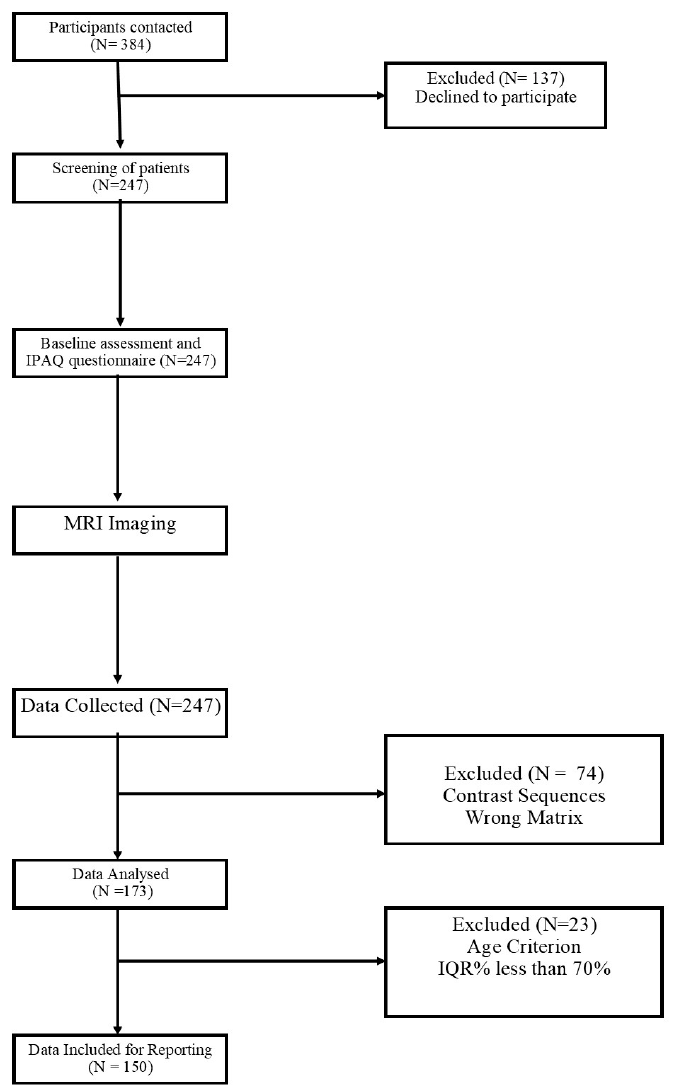
Figure 2. STROBE flow diagram.